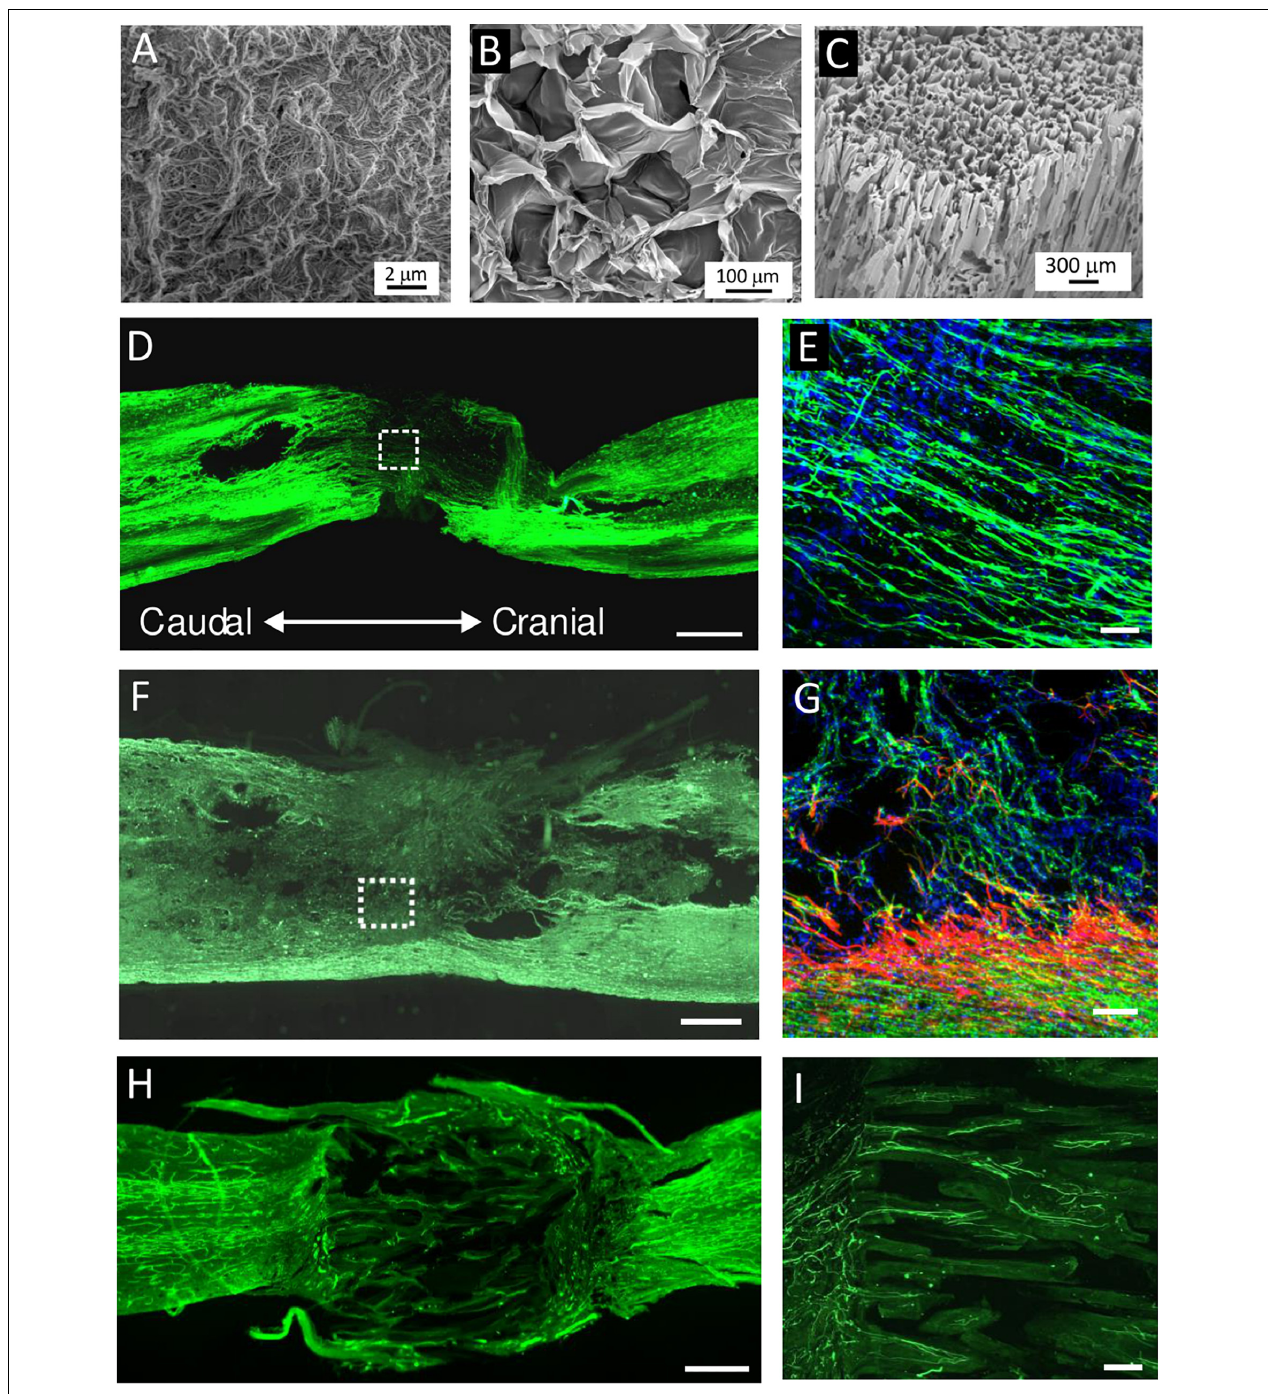
FIGURE 4 | (A–C) SEM micrographs of (A) extracellular matrix (ECM) hydrogel, (B) hyaluronic acid (HA) hydrogel modified with arginine–glycine–aspartic acid (RGD), and (C) highly superporous SIKVAV-modified superporous poly (2-hydroxyethyl methacrylate) hydrogel scaffolds with oriented pores. (D–I) Representative images of the longitudinal sections of the spinal cord lesion after hydrogel injection or implantation into the hemisection cavity. (D,E) Immunofluorescence staining for neurofilaments (NF-160, green) and (E) cell nuclei (DAPI, blue) at 2 weeks after the injection of ECM hydrogel derived from porcine spinal cord. (F,G) Immunofluorescence staining for neurofilaments (NF-160, green), (G) astrocytes (GFAP, red), and cell nuclei (DAPI, blue) at 8 weeks after HA–RGD hydrogel implantation; the square in panel (F) is shown under the higher magnification inset in panel (G) . (H,I) Immunofluorescence staining for (H) blood vessels (RECA) and (I) neurofilaments (NF-160, green) at 2 months after the implantation of SIKVAV-modified superporous poly (2-hydroxyethyl methacrylate) hydrogel with parallel-oriented pores. Scale bar: (D,F,H) 500 µ mm, (E,G) 50 µ mm, and (I) 100 µ mm. Modified from (A) Koci et al. (2017), (D,E) Tukmachev et al. (2016), (B,F,G) Zaviskova et al. (2018), and (C,H,I) Kubinova et al. (2015).